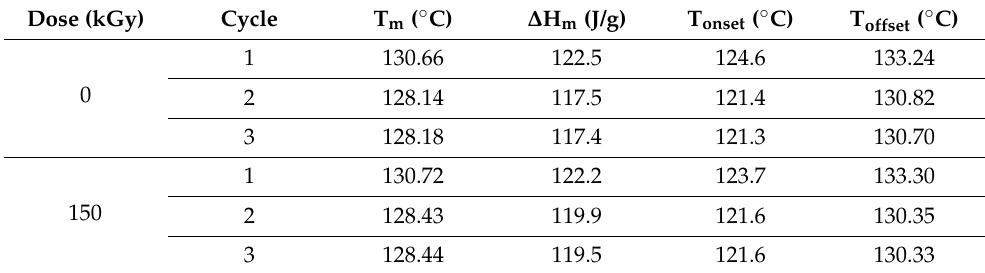
Table 6. Kinetic parameters of the melting curve of (CB + Gr)/(LLD + HD).